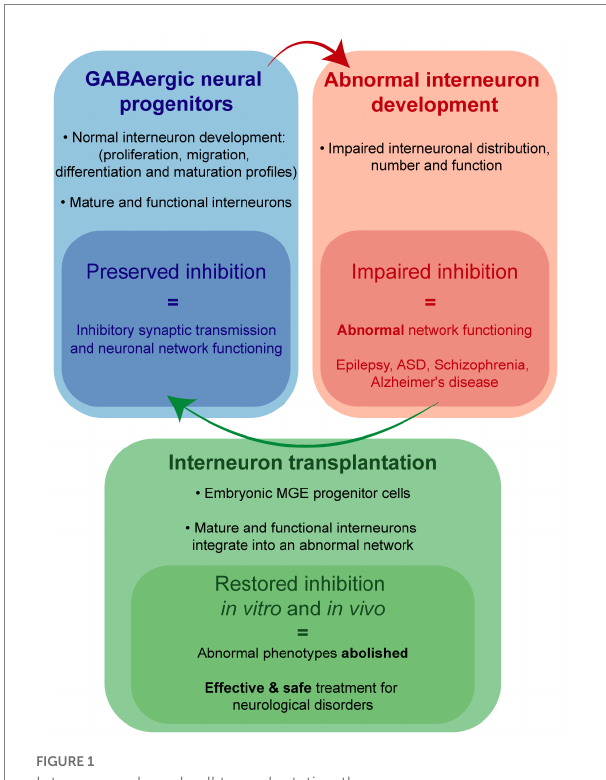
FIGURE 1 Interneuron-based cell transplantation